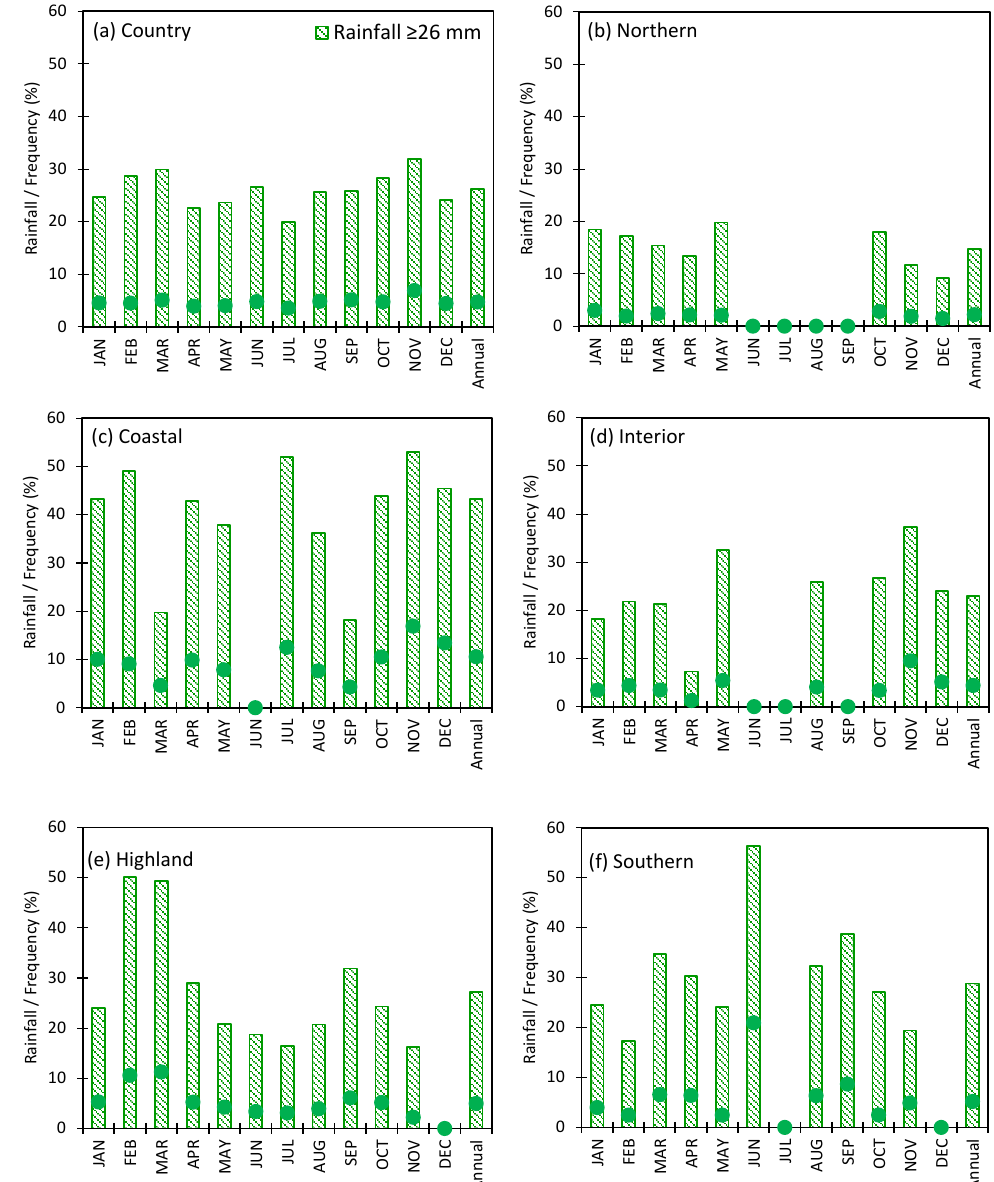
Figure 15. Contribution of extreme rainfall to total amounts (%), and extreme event frequency (%) at the ≥ 26 mm threshold in Saudi Arabia and five climate regions for the period 1978–2019. Annually, fewer than 10% of extreme events contributed 26% of the total rainfall (24 mm), while more than 90% of events contributed the other 74% (66 mm) for the entire country. ( a ) Country. ( b ) Northern. ( c ) Coastal. ( d ) Interior. ( e ) Highland. ( f ) Southern.